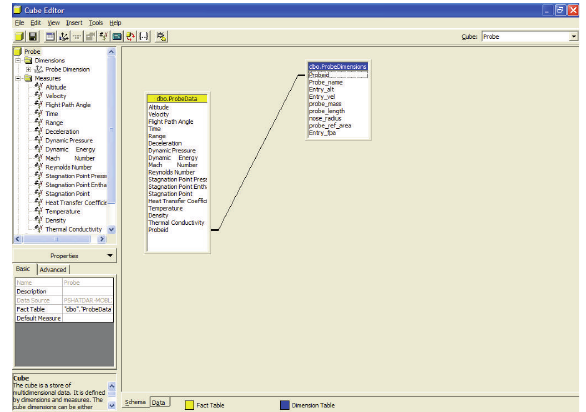
Figure 5: Dimensions modeled in OLAP cube for a planetary